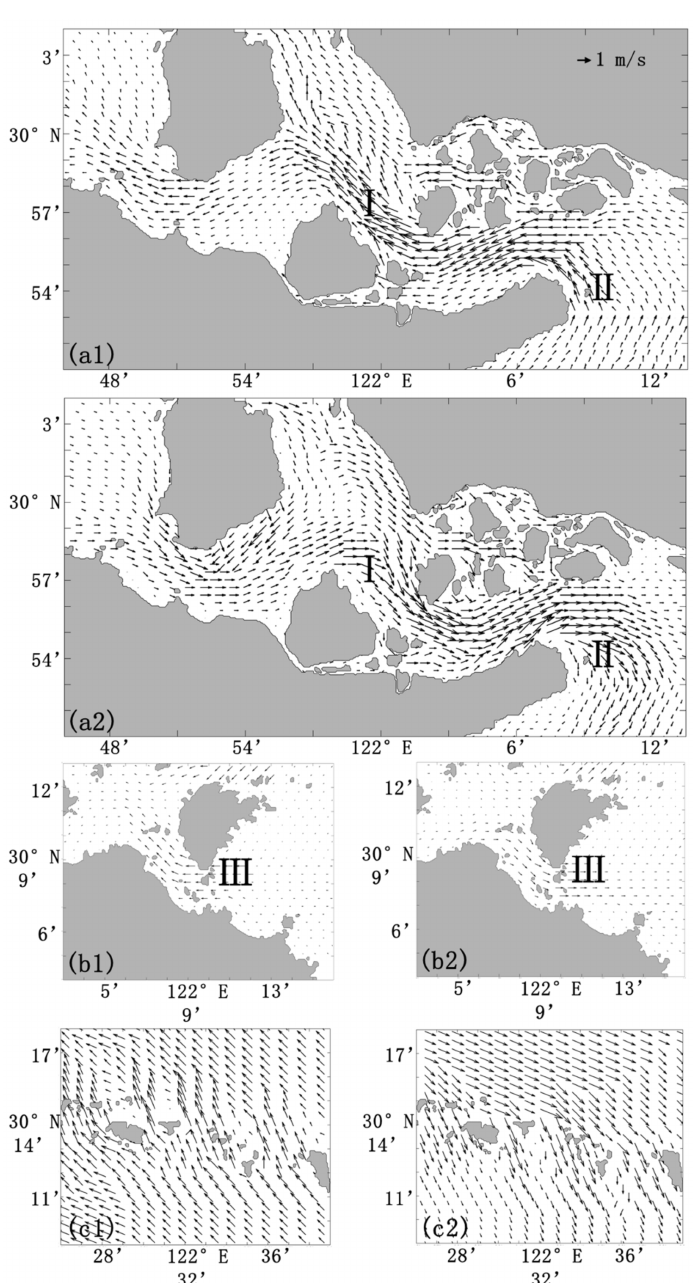
Figure 7. Tidal currents at maximum flood in ( a1 ) the Luotou Channel, ( b1 ) the Guanmen Channel, and ( c1 ) the Dongji Islands. Tidal currents at maximum ebb in ( a2 ) the Luotou Channel, ( b2 ) the Guanmen Channel, and ( c2 ) the Dongji